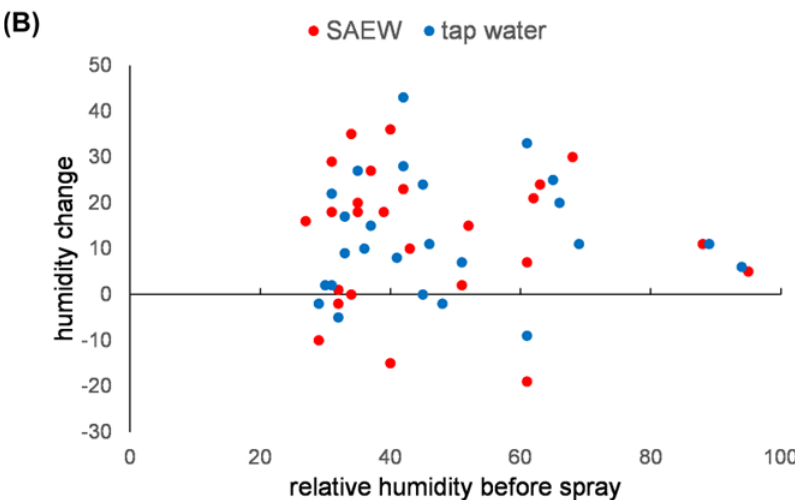
Figure 9. Environmental change in the greenhouse by spraying SAEW. ( A ) The temperature in the greenhouse was monitored before and after SAEW and tap water spray. The temperature change was plotted against the temperature before spraying. ( B ) The relative humidity in the greenhouse was monitored before and after SAEW and tap water spray. The humidity change was plotted against the relative humidity before spraying.